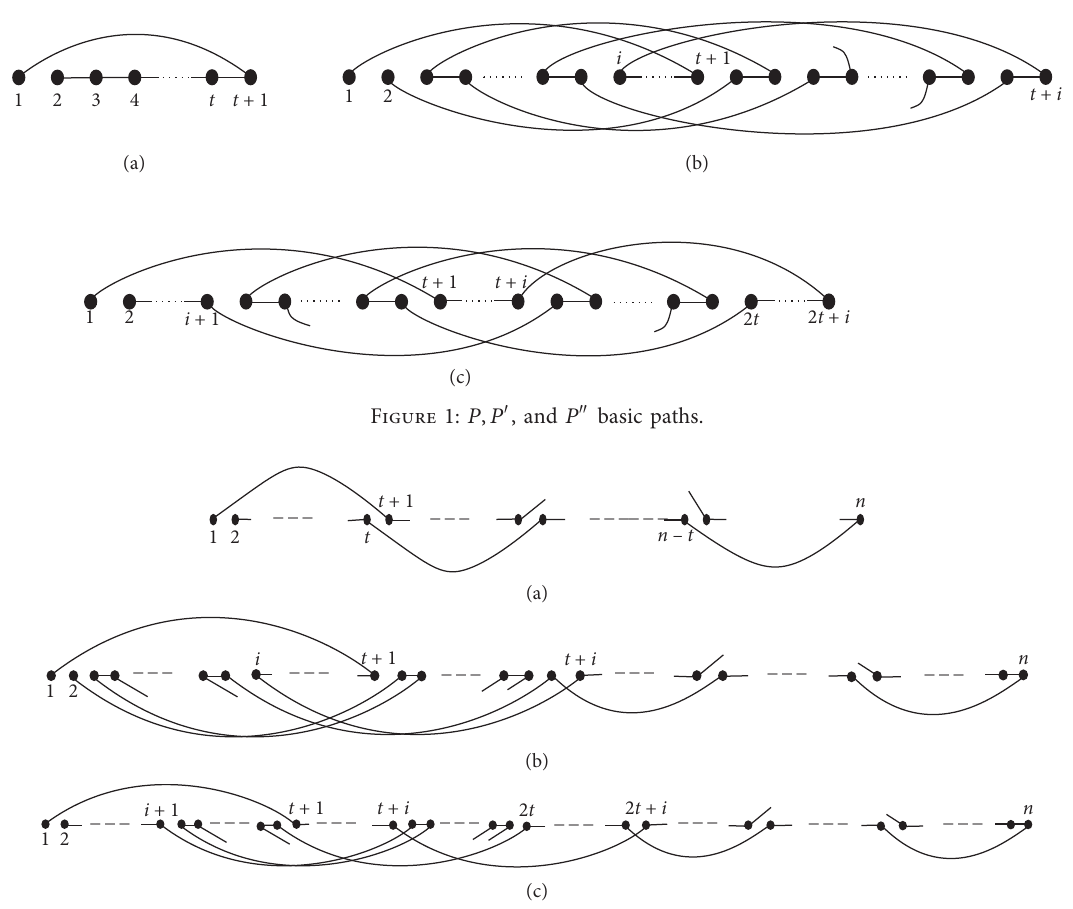
Figure 1: P,P ′ , and P ″ basic paths.